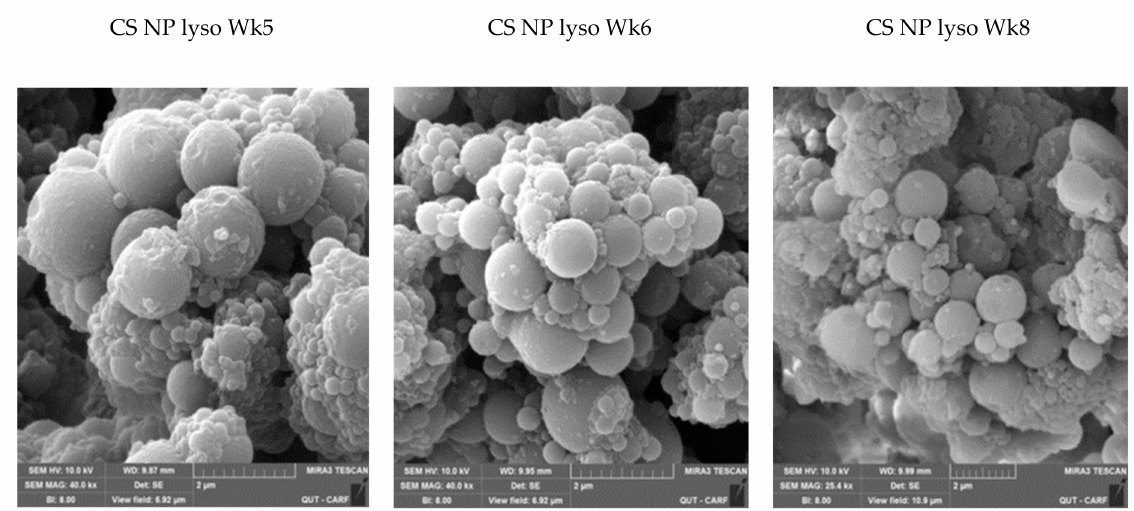
Figure 5. SEM images of CS NPs before and after incubating in 0.2 mg/mL lysozyme solution at different time intervals.